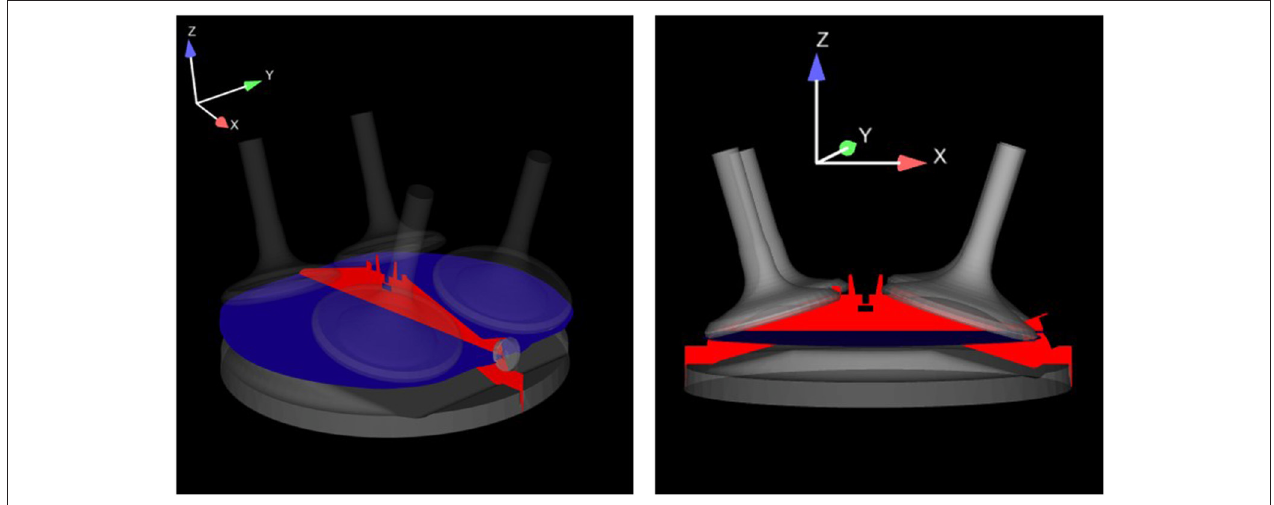
FIGURE 6 | Location of horizontal (blue) and vertical (red) cut-planes selected for capturing the temperature and equivalence ratio